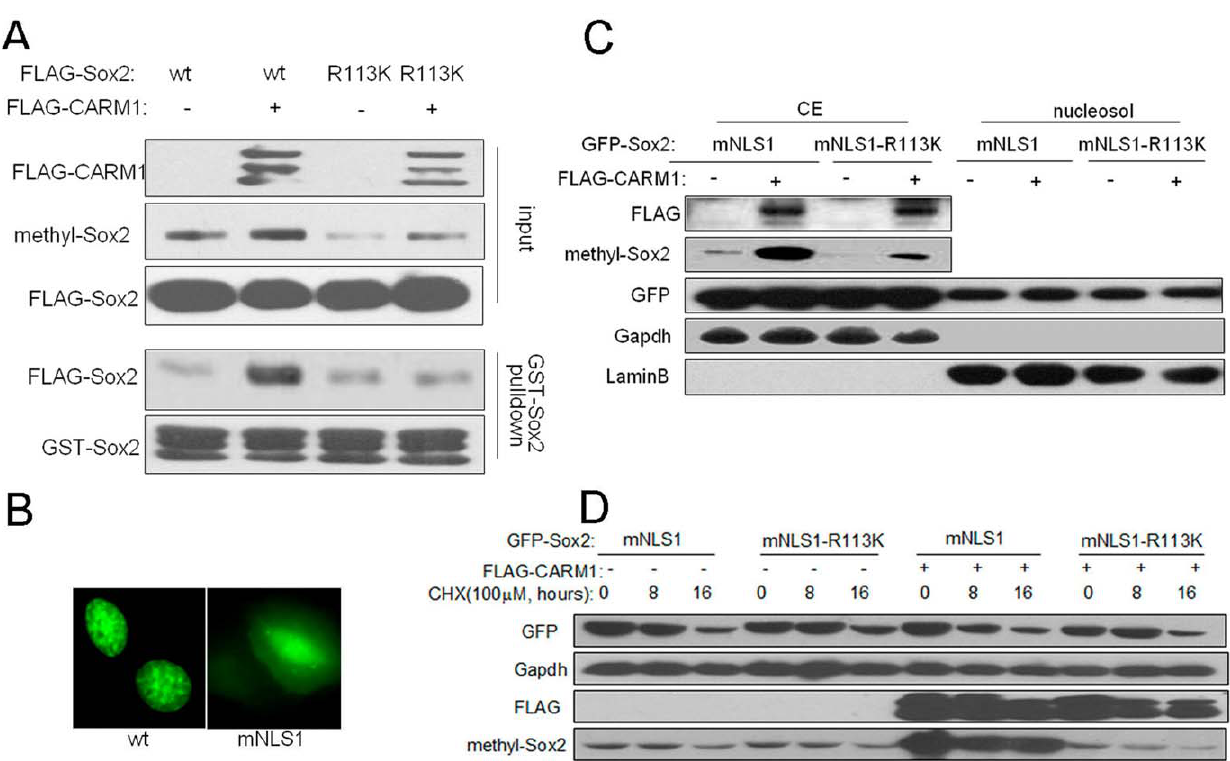
Figure 4. The effects of Arg113 methylation on Sox2 self-association, subcellular localization and protein stability. (A) The effect of CARM1-mediated Sox2 methylation on Sox2 self-association. FLAG-Sox2 wild-type and mutant-c were expressed together with ( + ) or without (-) FLAG-CARM1 in MCF7 cells. WCEs were immunoblotted to examine the Sox2 methylation level. The remaining lysates were subjected to pull-down assays with bacterially expressed GST-Sox2 protein. (B) Localization of wild-type and R113K mutant GFP-tagged Sox2 in MCF7 cells. (C) The impact of CARM1-mediated methylation on the GFP-Sox2-mNLS1 distribution in cell fractions. GFP-tagged Sox2-mNLS1 with or without R113K substitution was expressed in MCF7 cells, and cell fractions were prepared to detect Sox2 distribution. CE: cytoplasmic extracts; nucleosol: soluble nuclear materials. (D) The effect of CARM1 on GFP-Sox2-mNLS1 protein stability. GFP-Sox2-mNLS1 and GFP-Sox2-mNLS1-R113K were expressed in MCF7 cells to examine the effect of CARM1 on Sox2 degradation. Forty-eight hours later, cells were treated with cycloheximide (CHX) as indicated, and Sox2 protein levels were analyzed by immunoblotting assays.